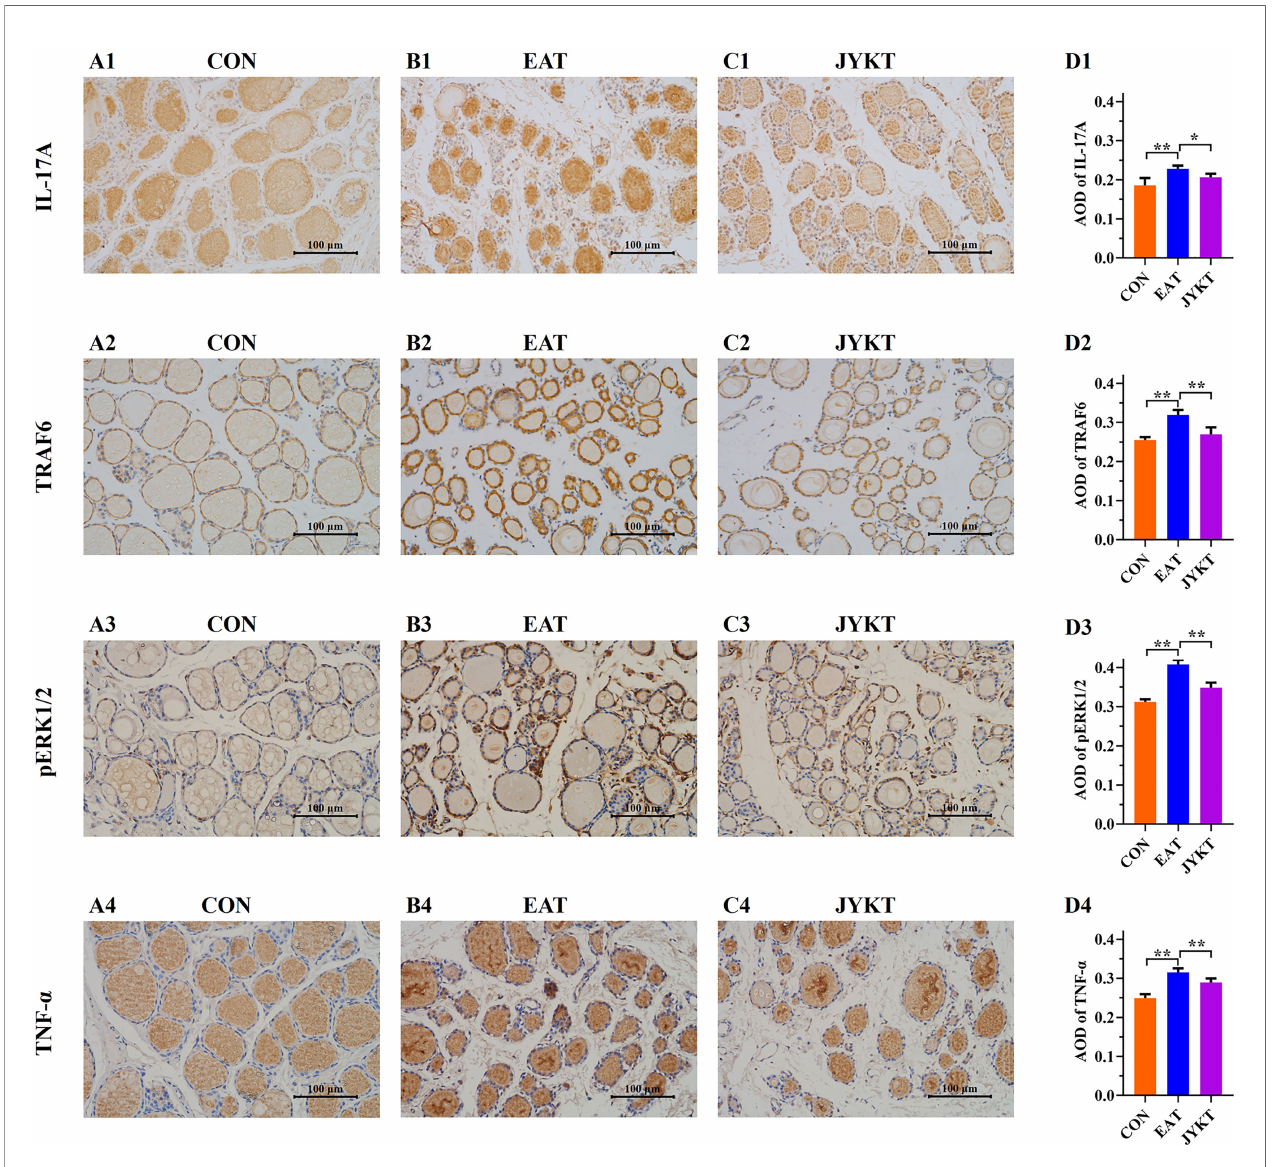
FIGURE 8 | Immunoreactivity of IL-17A, TRAF6, pERK1/2 and TNF- a of thyroid in the CON (A1 – 4) , EAT (B1 – 4) and JYKT group (C1 – 4) (400×). Average optical densities among groups (D1 – 4) . ** P < 0. 01, * P < 0.